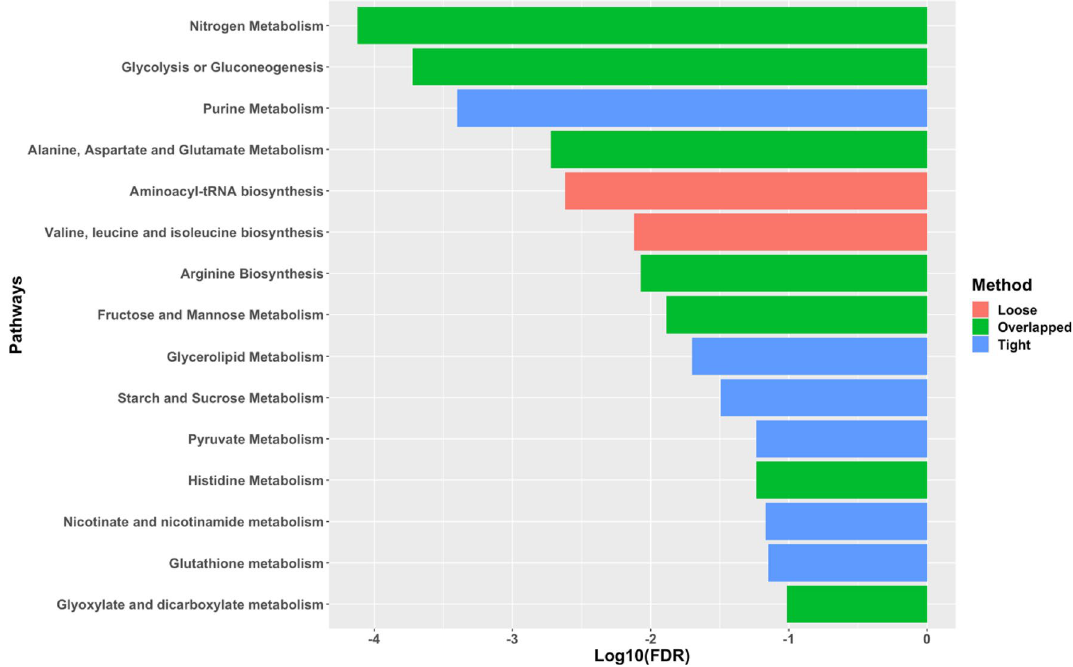
Figure 1. Biological pathways identified by Joint Pathway Analysis of differentially expressed genes and differentially abundant metabolites between WB-affected and unaffected chickens. FDR false discovery